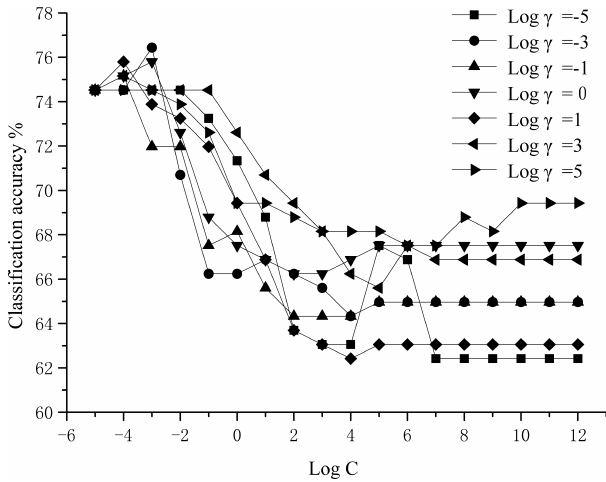
Fig. 6. Dependence of classi¯cation accuracy on parameters C and (cid:1) for a sigmoid SVM. The base of log C is 2 and the base of log (cid:1) is 2.